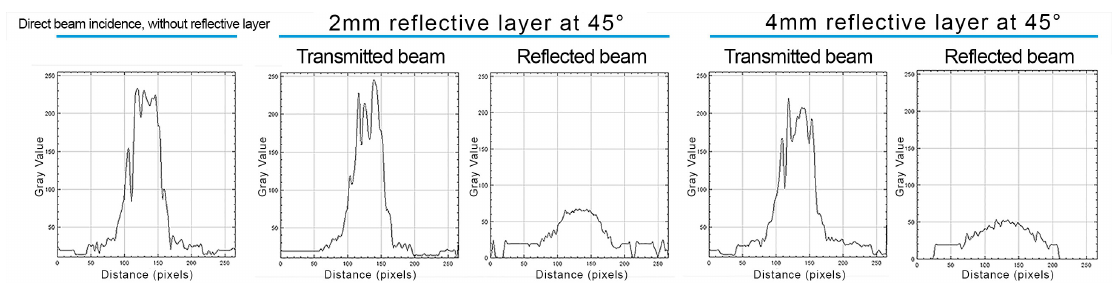
Figure 6. Transmitted and reflected beam profiles: directly from the source and through an acrylic sheet of 2 mm and 4 mm thickness placed at 45 o